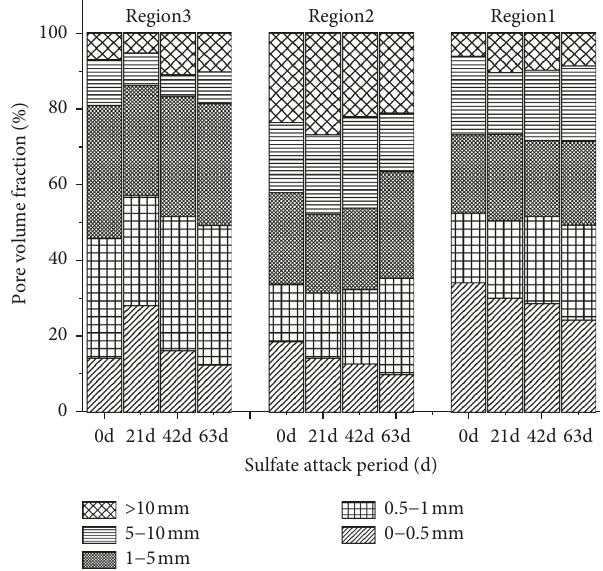
Figure 22: Pore volume of different regions with sulfate attack period in different divided regions. Table 6: Porosity and pore volume in different divided regions in